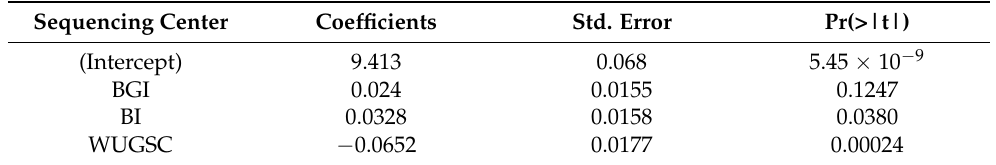
Table 3. Coefficient, standard error, and p value of the coefficient from the hierarchical mixed model using the number of derived singletons as the dependent variable. For this analysis, we only considered sequencing centers that sequenced samples across all populations.